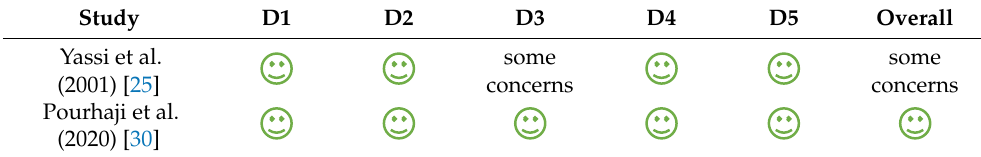
Table 3. Quality assessment for randomized controlled trials—ROB 2.0.